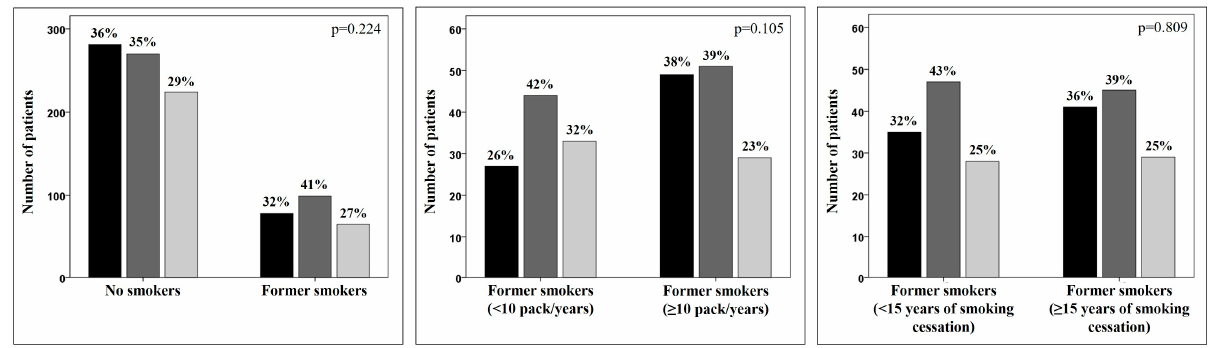
Figure 1. Clinical assessment according to the GINA recommendations definition of control. Black, gray and light gray bars represent patients not-controlled, partially controlled, and controlled, respectively.